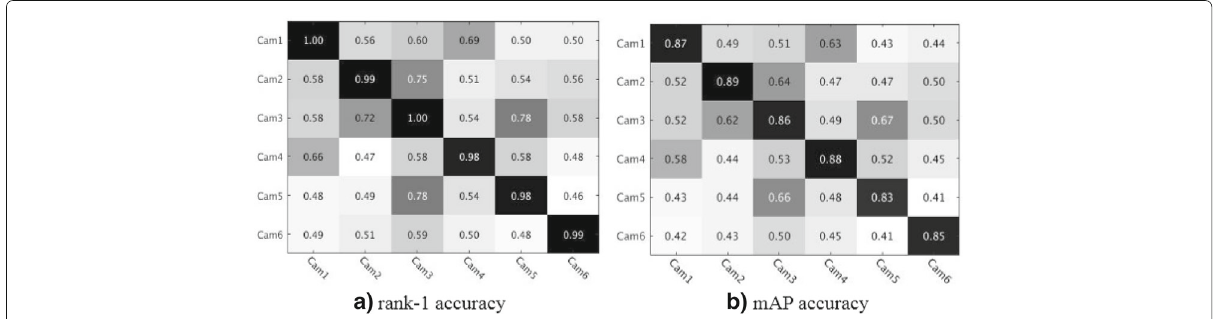
Fig. 5 Re-ID performance between camera pairs on Market1501 database. a Rank-1 accuracy. b mAP accuracy